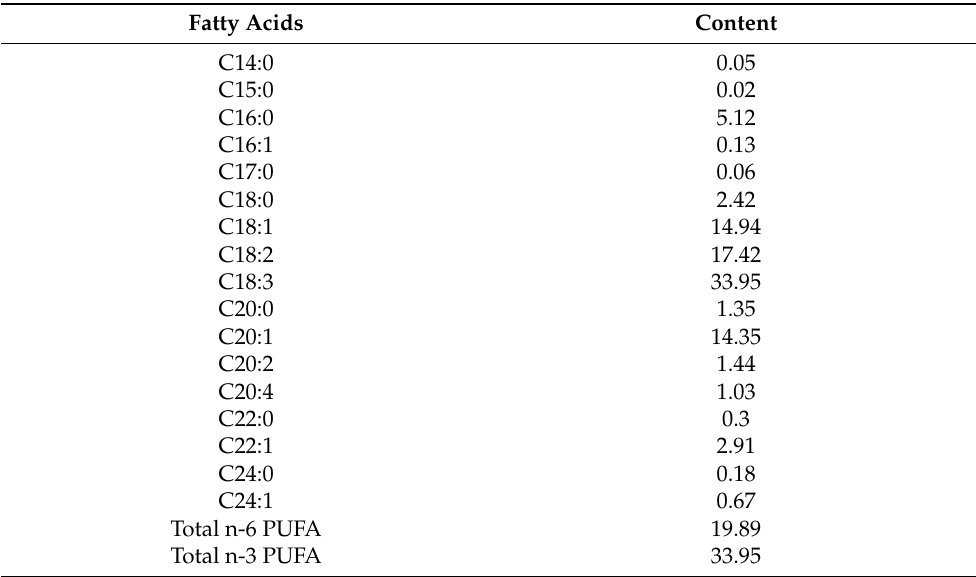
Table 1. Fatty acid composition of camelina oil. The contents of particular fatty acids are presented as a percentage of total